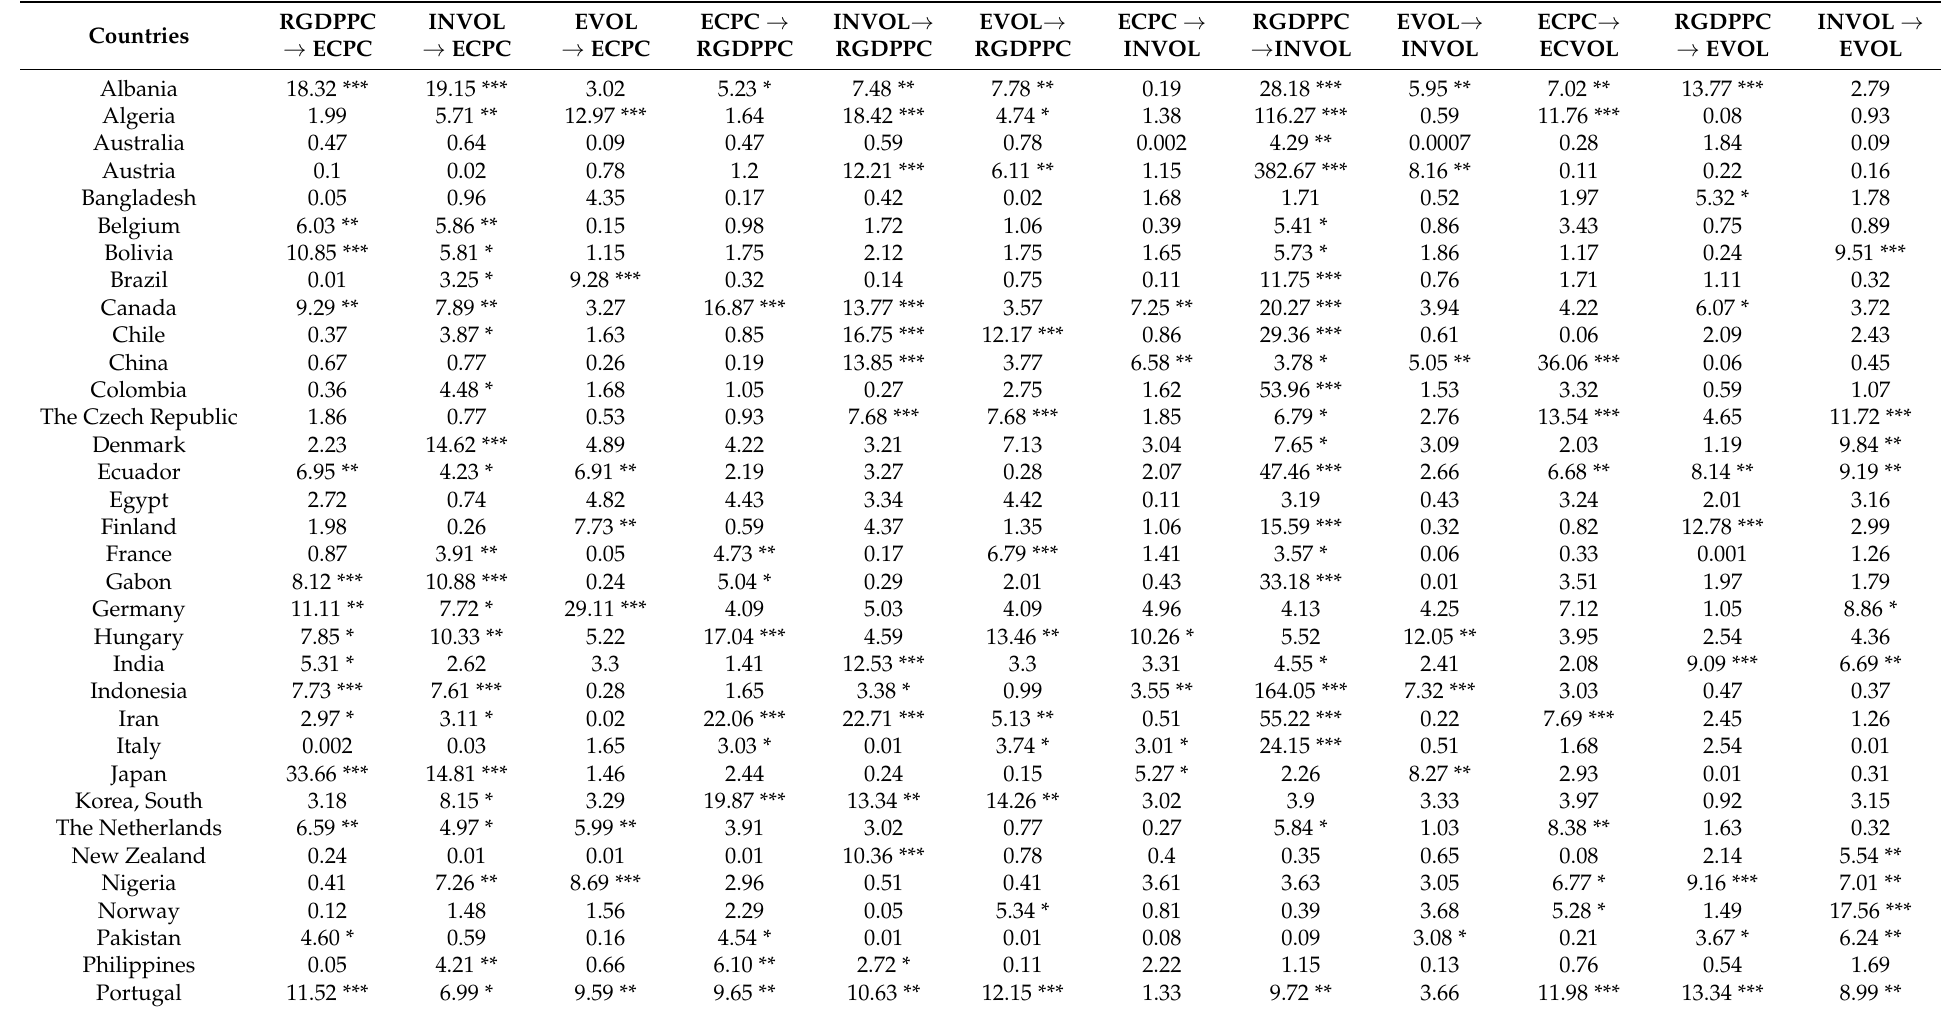
Table A6. Short-run Granger causality results (F